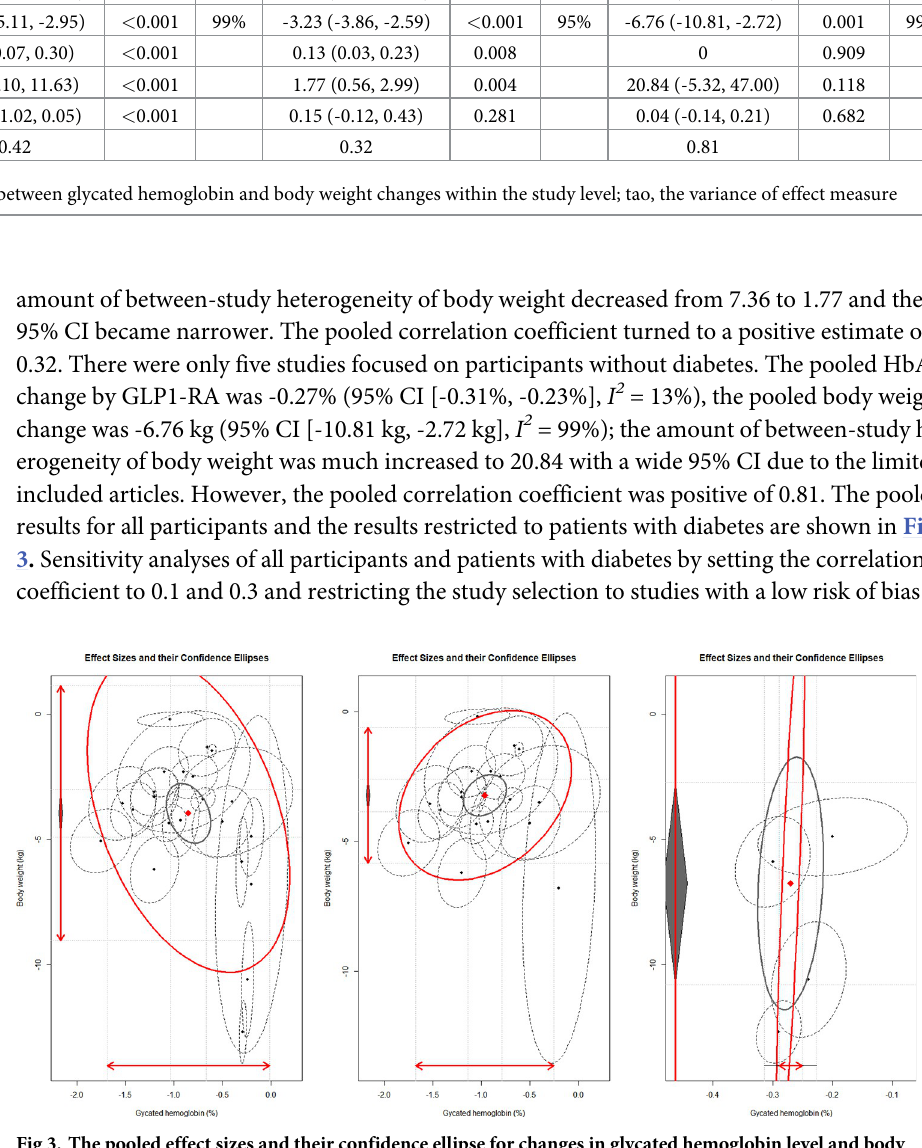
Fig 3. The pooled effect sizes and their confidence ellipse for changes in glycated hemoglobin level and body weight in patients treated with a glucagon-like peptide-1 receptor agonist and placebo, in participants not restricted and restricted to diabetes. (left) The pooled effect sizes and their confidence ellipse of the changes in the glycated hemoglobin level and body weight, in a comparison of glucagon-like peptide-1 receptor agonists and placebo in all participants. (middle) The pooled effect sizes and their confidence ellipse for changes in the glycated hemoglobin level and body weight, in a comparison of glucagon-like peptide-1 receptor agonists and placebo in patients with diabetes. (right) The pooled effect sizes and their confidence ellipse for changes in the glycated hemoglobin level and body weight, in a comparison of glucagon-like peptide-1 receptor agonists and placebo in patients without diabetes. x- axis: Effects of glucagon-like peptide-1 receptor agonists on glycated hemoglobin level; y-axis: effects of glucagon-like peptide-1 receptor agonists on body weight changes; black dots: individual studies; ellipses with dashed lines: 95% confidence interval; red diamond: pooled effect and 95% confidence interval; smaller gray ellipse: 95% confidence interval; larger red ellipse: 95% prediction interval.